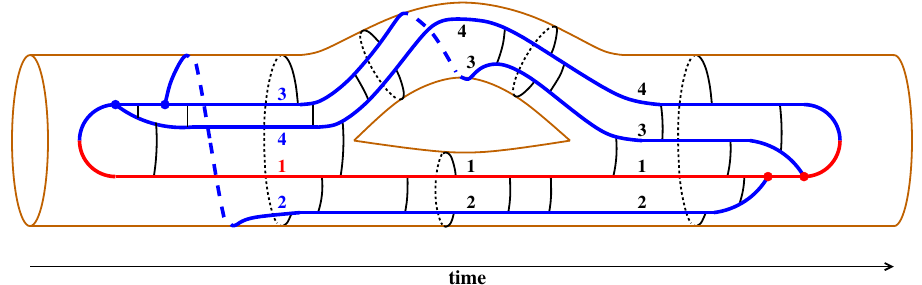
Figure 6 . A topological depiction of the O (1 /N 2 ) transition (1234) → (12)(34) → (1243) between N = ∞ color singlet states during the 4-gluon phase of evolution of figure 3. The black lines indicate (2-point) examples of correlations of interactions with the medium, which for N = ∞ are allowed only between